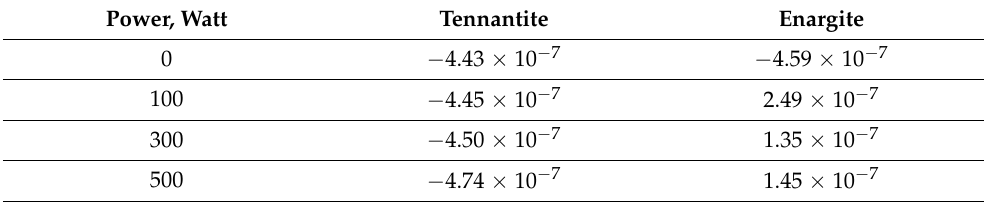
Table 1. Magnetic susceptibility of tennantite and enargite before and after microwave irradiation.